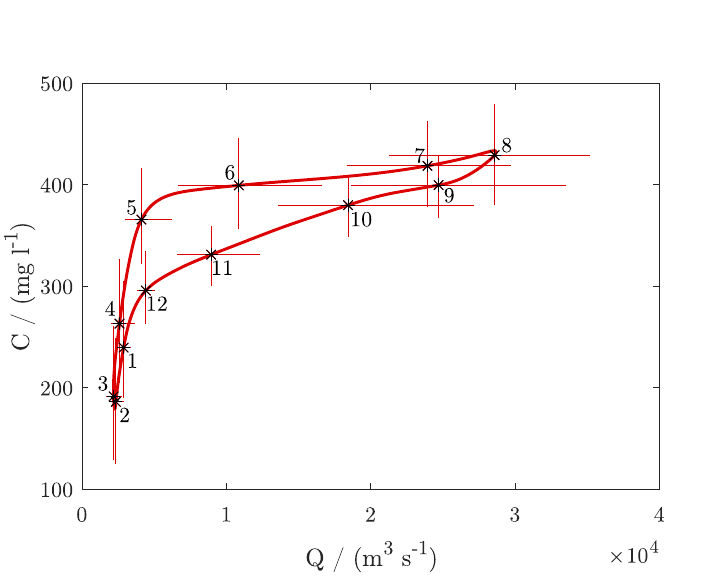
Fig 6. Hysteresis between the discharge and washload concentration over the annual cycle, with a higher sediment concentration during the rising and a lower sediment concentration during the falling hydrograph. The red line indicates the concentration averaged over the 16 years and smoothed over a 30-day interval. Crosshairs indicate 16 th - 84 th percentile ranges for discharge and concentration on the 15 th day of each month.